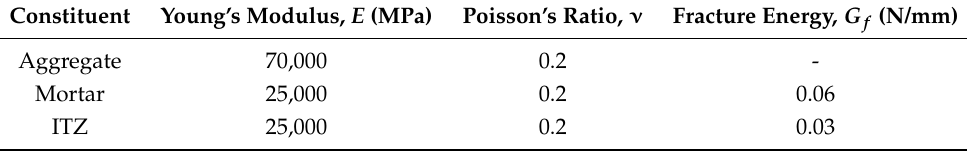
Table 2. Material properties [5]. ITZ, interfacial transition